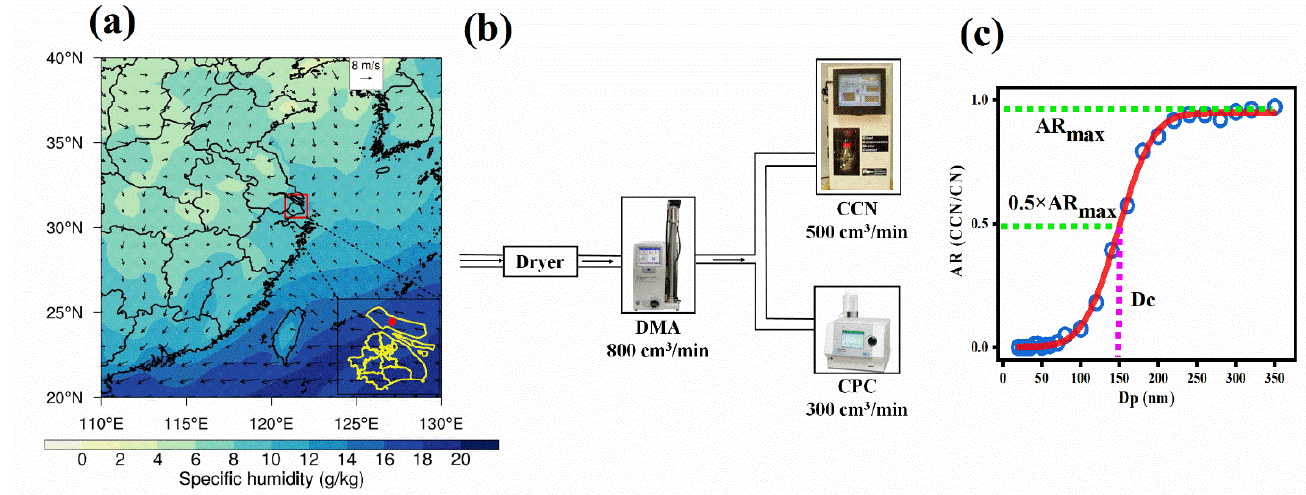
Figure 1. ( a ) The averaged 850 hPa wind field and 10 m specific humidity from 0:00 to 7:00 (LT) on 2 November 2019. The red dot at the bottom right is the field experimental site. ( b ) The instrumental set ‐ up. ( c ) Measured (circle) and fitted size ‐ resolved particle activation ratio curves.